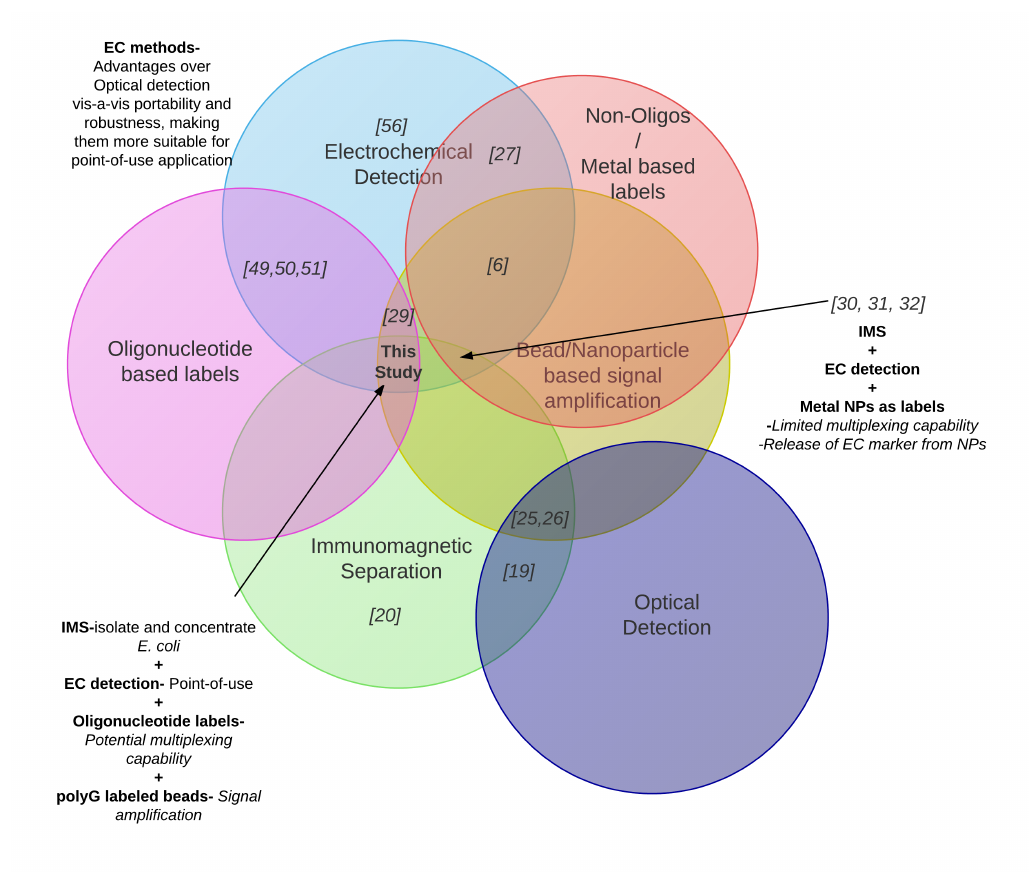
Figure 2. Review of recent point-of-use methods used for detection of proteins and DNA